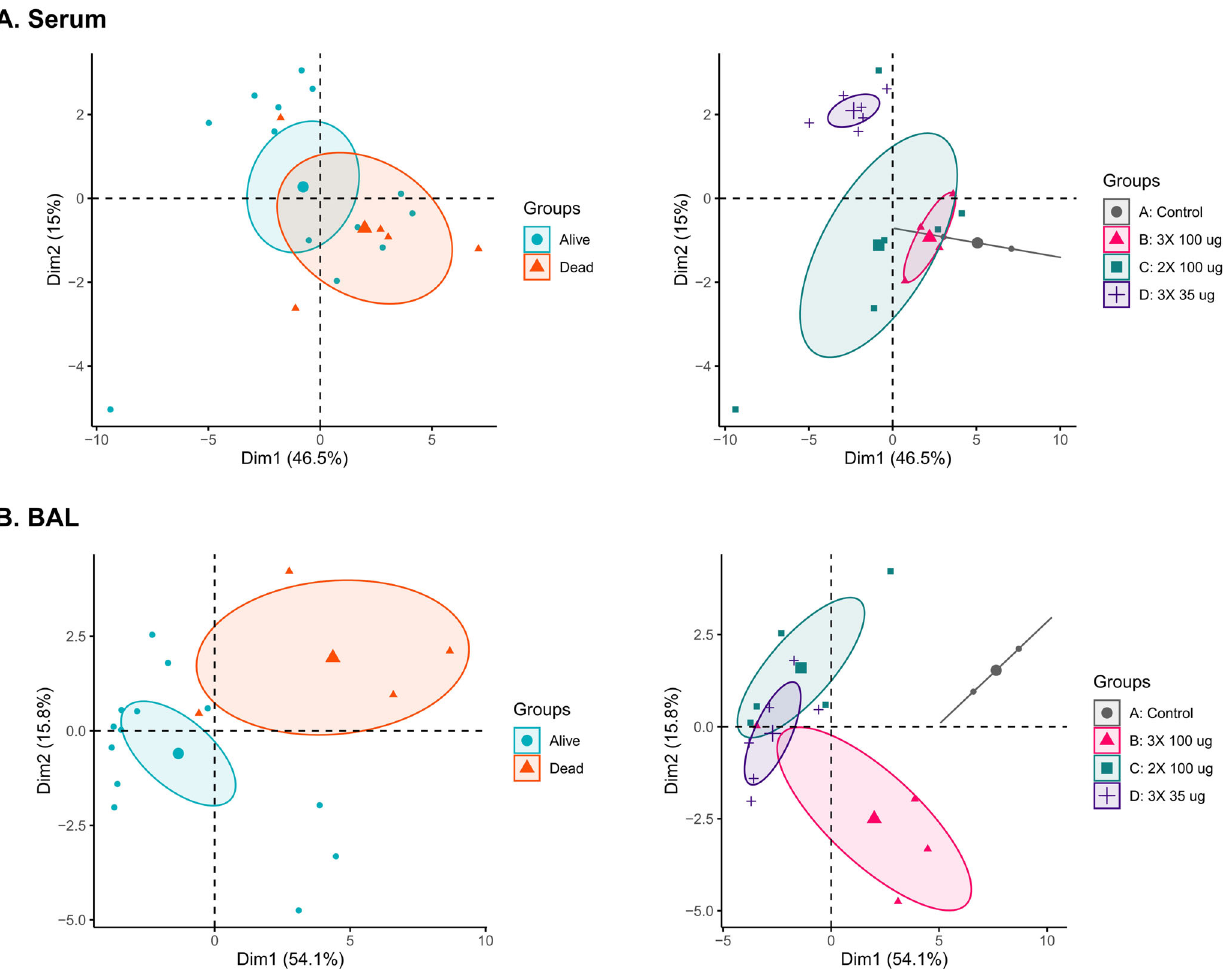
Fig. 2 Principal component analysis (PCA) of cytokine and chemokine levels in sera and BALs. Scatterplots of principal components 1 and 2 of log 2 -transformed 29-plex analyte changes in A sera and B BALs in RT-challenged macaques. Each point represents an individual animal, with ellipses representing 95% con fi dence intervals around the means for each group. The left plots show ellipses around survivors and decedents, while the right plots show ellipses around each experimental group, with colors as described in the (Fig. 4C). Thus, both EPT and TNA 1:10 have moderate value in predicting outcome following RT challenge in the NHP model.